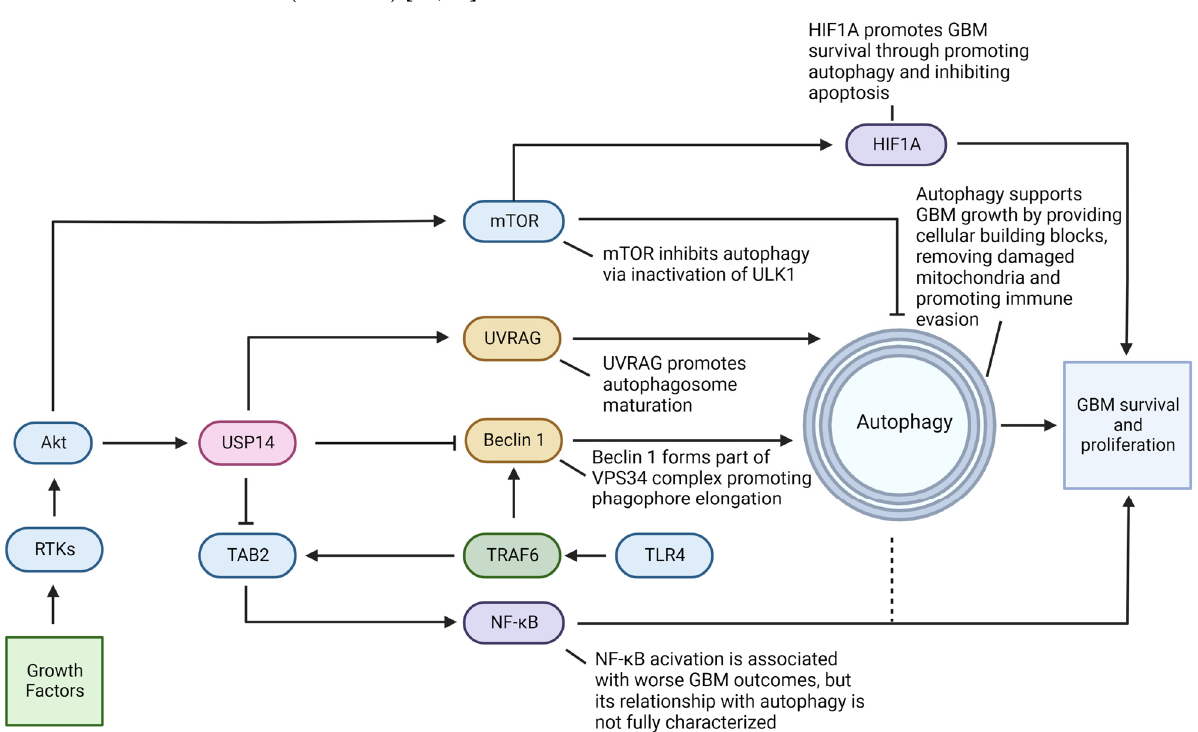
Figure 3. The USP14 regulation of pathways leading to autophagy and GBM survival. USP14 is a deubiquitinase, which directly regulates multiple autophagy-related proteins. USP14 is activated by Akt via phosphorylation, while Akt is a downstream effector of the receptor tyrosine kinases (RTKs), which are activated by growth factor receptors. USP14 antagonizes the E3 ligase tumor necrosis factor (TNF) receptor–associated factor 6 (TRAF6) by deubiquitinating and inactivating its substrates Beclin 1 and the transforming growth factor beta (TGF β )-activated protein kinase 1 (TAK1)-binding protein 2 (TAB2). Beclin 1 is a critical pro-autophagy related protein while TAB2 is an activator of the nuclear factor-kappaB (NF- κ B) signaling. USP14 also stabilizes the ultraviolet (UV) radiation resistance-associated gene (UVRAG) protein, which is known to support the maturation of autophagosomes. ULK1, Unc-51 like autophagy activating kinase 1; VPS34, vacuolar protein sorting